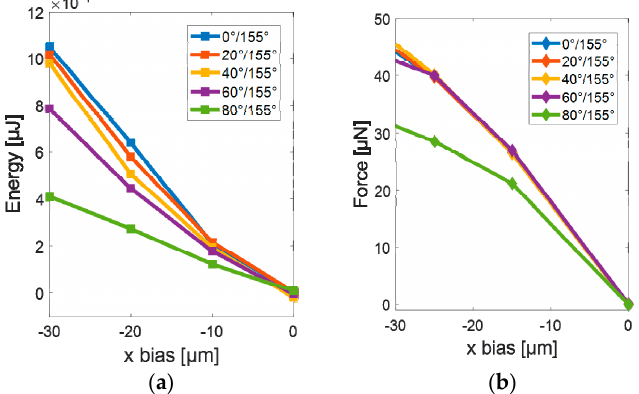
Figure 6. Surface energy and the restoring force as the function of x bias regarding different wetting contrast of grooves: ( a ) Surface energy versus x-bias with a contact angle of the groove from 0° to 80°; ( b ) Restoring force versus x-bias with a contact angle of the groove from 0° to 80°.